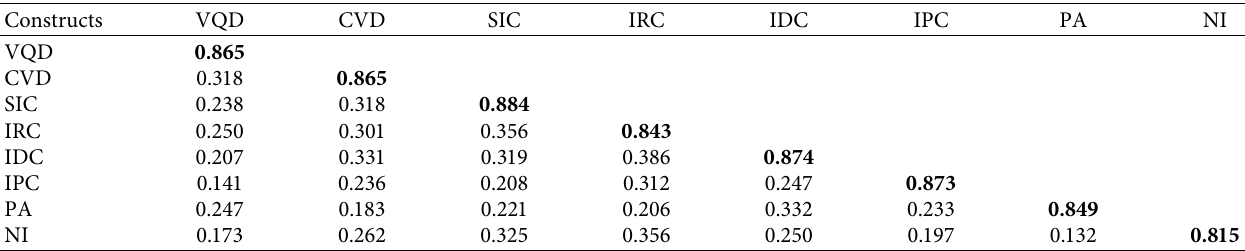
Table 6: Correlation scores and discriminant validity